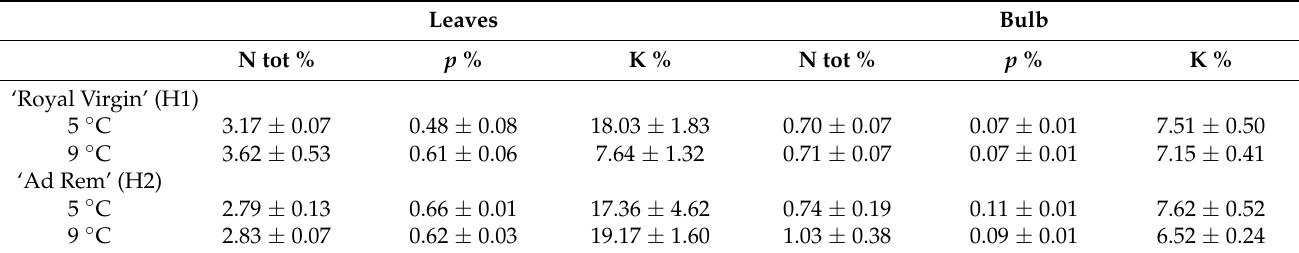
Table 2. Concentration of the main macronutrients (g/100 g DM) in leaves and bulbs of the two hybrids of Tulipa gesneriana L. ‘Royal Virgin’ and ‘Ad Rem’, grown hydroponically from bulbs subjected to two preparation procedures, 5 ◦ C and 9 ◦ C, at the end of the growing cycle. Mean values ± Standard error; n =